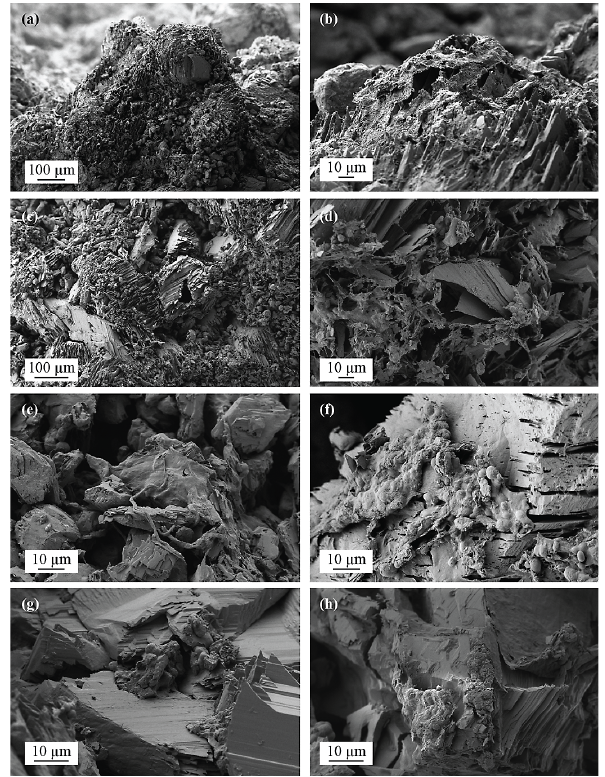
Fig. 6. SEM micrographs of the Gypsum Hill endolithic habitat. (a) Gypsum (CaSO 4 · 2H 2 O) forms from hydration of anhydrite (CaSO 4 ) , with exposed minerals having irregular, jagged topogra- phy that is often coated in allochthonous debris (b) that forms a surface crust. (c) Freeze–thaw action results in cleavage along crys- tal planes, increasing porosity and available surface area. (d) Gyp- sum affected by freeze–thaw weathering showing abundant colo- nization by endolithic microorganisms and associated EPS. (e, f) Subsurface gypsum colonized by both filamentous and coccoid mi- croorganisms and EPS. Note early stages of mineral weathering in (f) . (g) Microbial colonization of small pore space within the en- dolithic habitat. (h) Examination of the microbe–mineral contact shows original mineral structure, suggesting that microbial activity does not enhance chemical